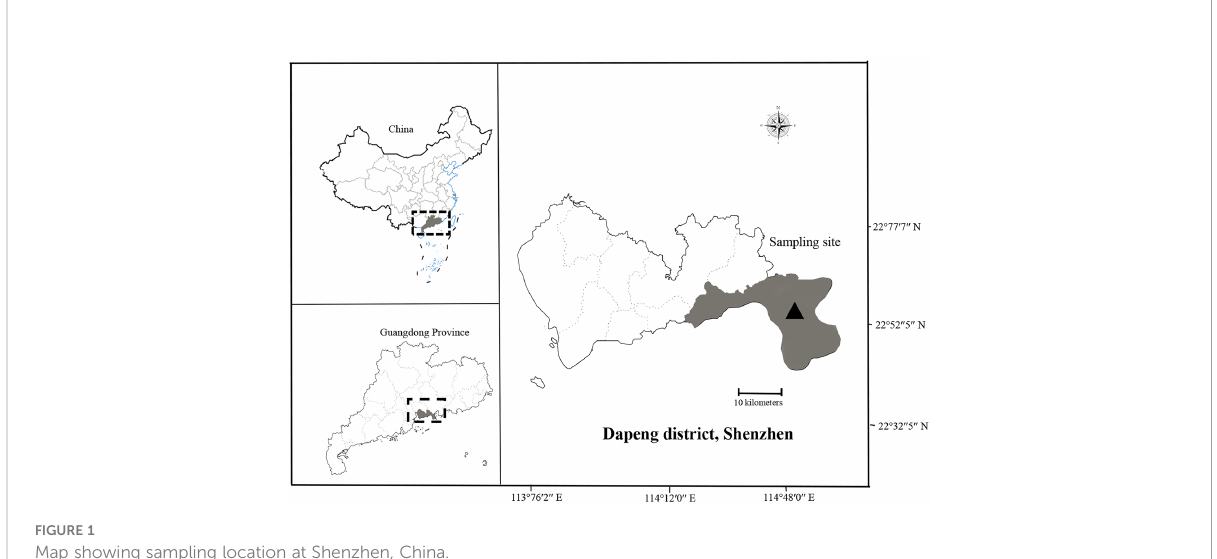
FIGURE 1 Map showing sampling location at Shenzhen,